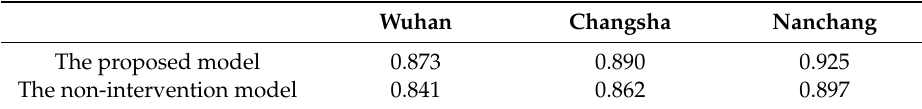
Table 3. The fuzzy kappa of the simulation results in diverse urban areas.